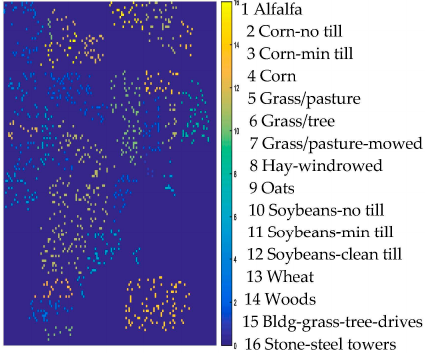
Figure 5. AVIRIS Indian Pines training maps.